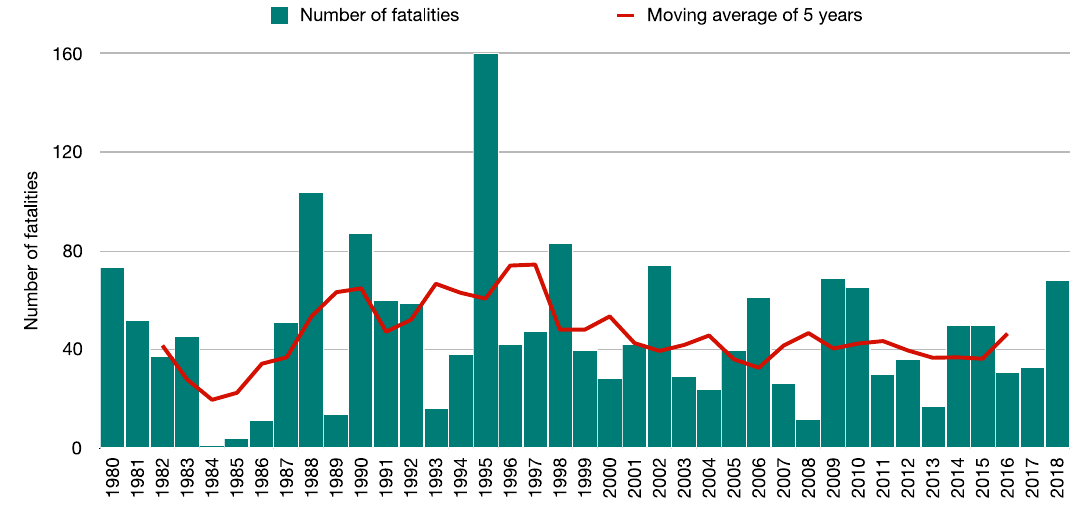
Figure 16. Evolution of the annual number of flood fatalities in the MEFF v2.0 DB area.